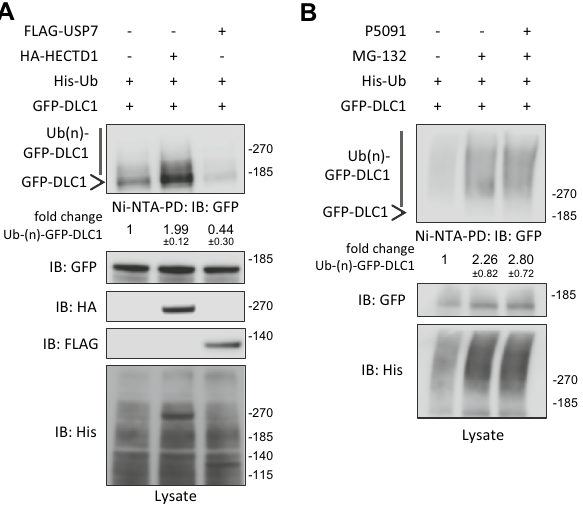
Figure 3. HECTD1 and USP7 regulate DLC1 ubiquitination. ( A ) HEK293T cells were transiently transfected with vectors encoding the indicated constructs. The next day, cells were treated with the proteasome inhibitor MG-132 (10 µM) before lysis. Lysates were subjected to pulldown with Ni–NTA-agarose. Pulldowns and lysates were analyzed by immunoblotting with the indicated antibodies. ( B ) MCF7 cells were transiently transfected with vectors encoding the indicated constructs. The next day, cells were treated with MG-132 (10 µM), P5091 (20 µM) as indicated or DMSO as a control for 6 h before lysis. Lysates were subjected to pulldown with Ni– NTA-agarose. Pulldowns and lysates were analyzed by immunoblotting with the indicated antibodies. ( A , B ) Western blots from three independent experiments were analyzed with ImageJ, the fold change in ubiquitinated GFP-DLC1 species was determined by normalizing their signal intensity to that of control sample, and is presented as mean ± s.d. Full-length western blots are provided as Supplementary